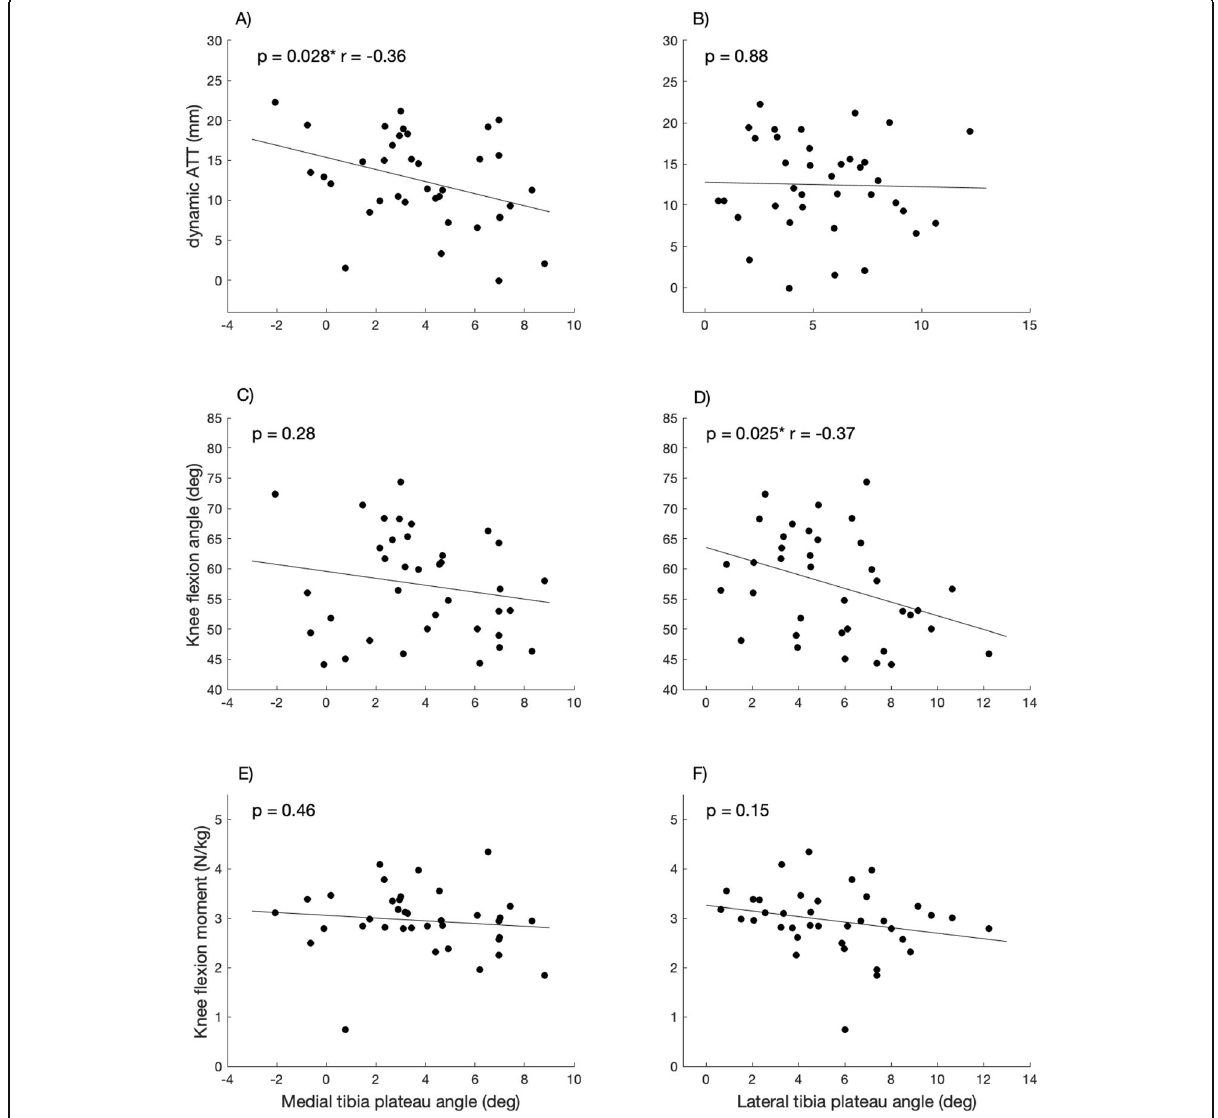
Fig. 3 Correlations between MPTPA and the maximal dynamic ATT ( a ), knee flexion angle ( c ) and knee extension moment ( e ), and between LPTPA and the maximal dynamic ATT ( b ), knee flexion angle ( d ) and knee extension moment ( f ). *: